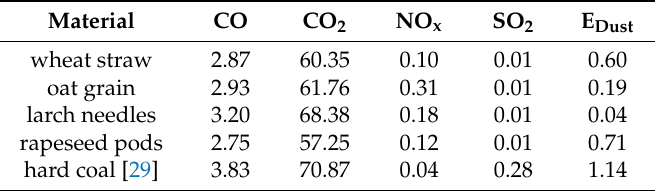
Table 3. Gas-dust emission indices for biomass per unit of energy (in kg · GJ − 1